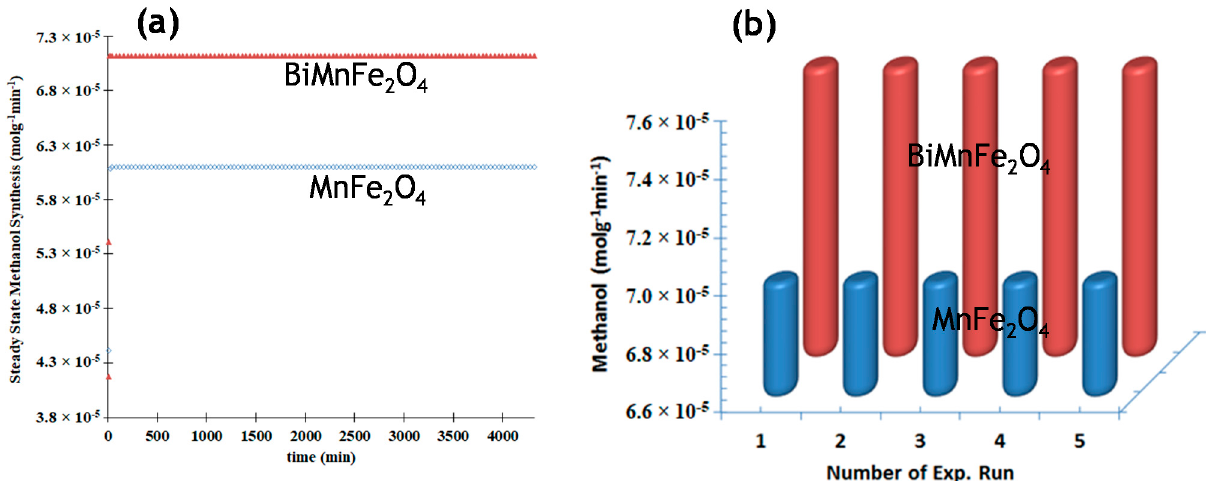
Figure 5. Life span/reusability of MnFe 2 O 4 and Bi-MnFe 2 O 4 for CO 2 conversion to MeOH. Reaction conditions: pressure: 1 bar, temp: 493 K, ( a ) extended time; 4320 min, GHSV: 22,000 h − 1 , feed ratio: 3/1 H 2 /CO 2 , ( b ) no. of runs: 5 (data collected after 90 min).